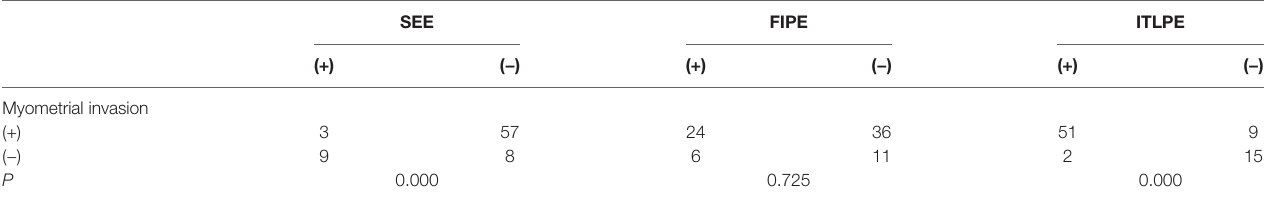
TABLE 2 | Correlation between SEE, FIPE, ITLPE, and myometrial invasion. SEE FIPE ITLPE